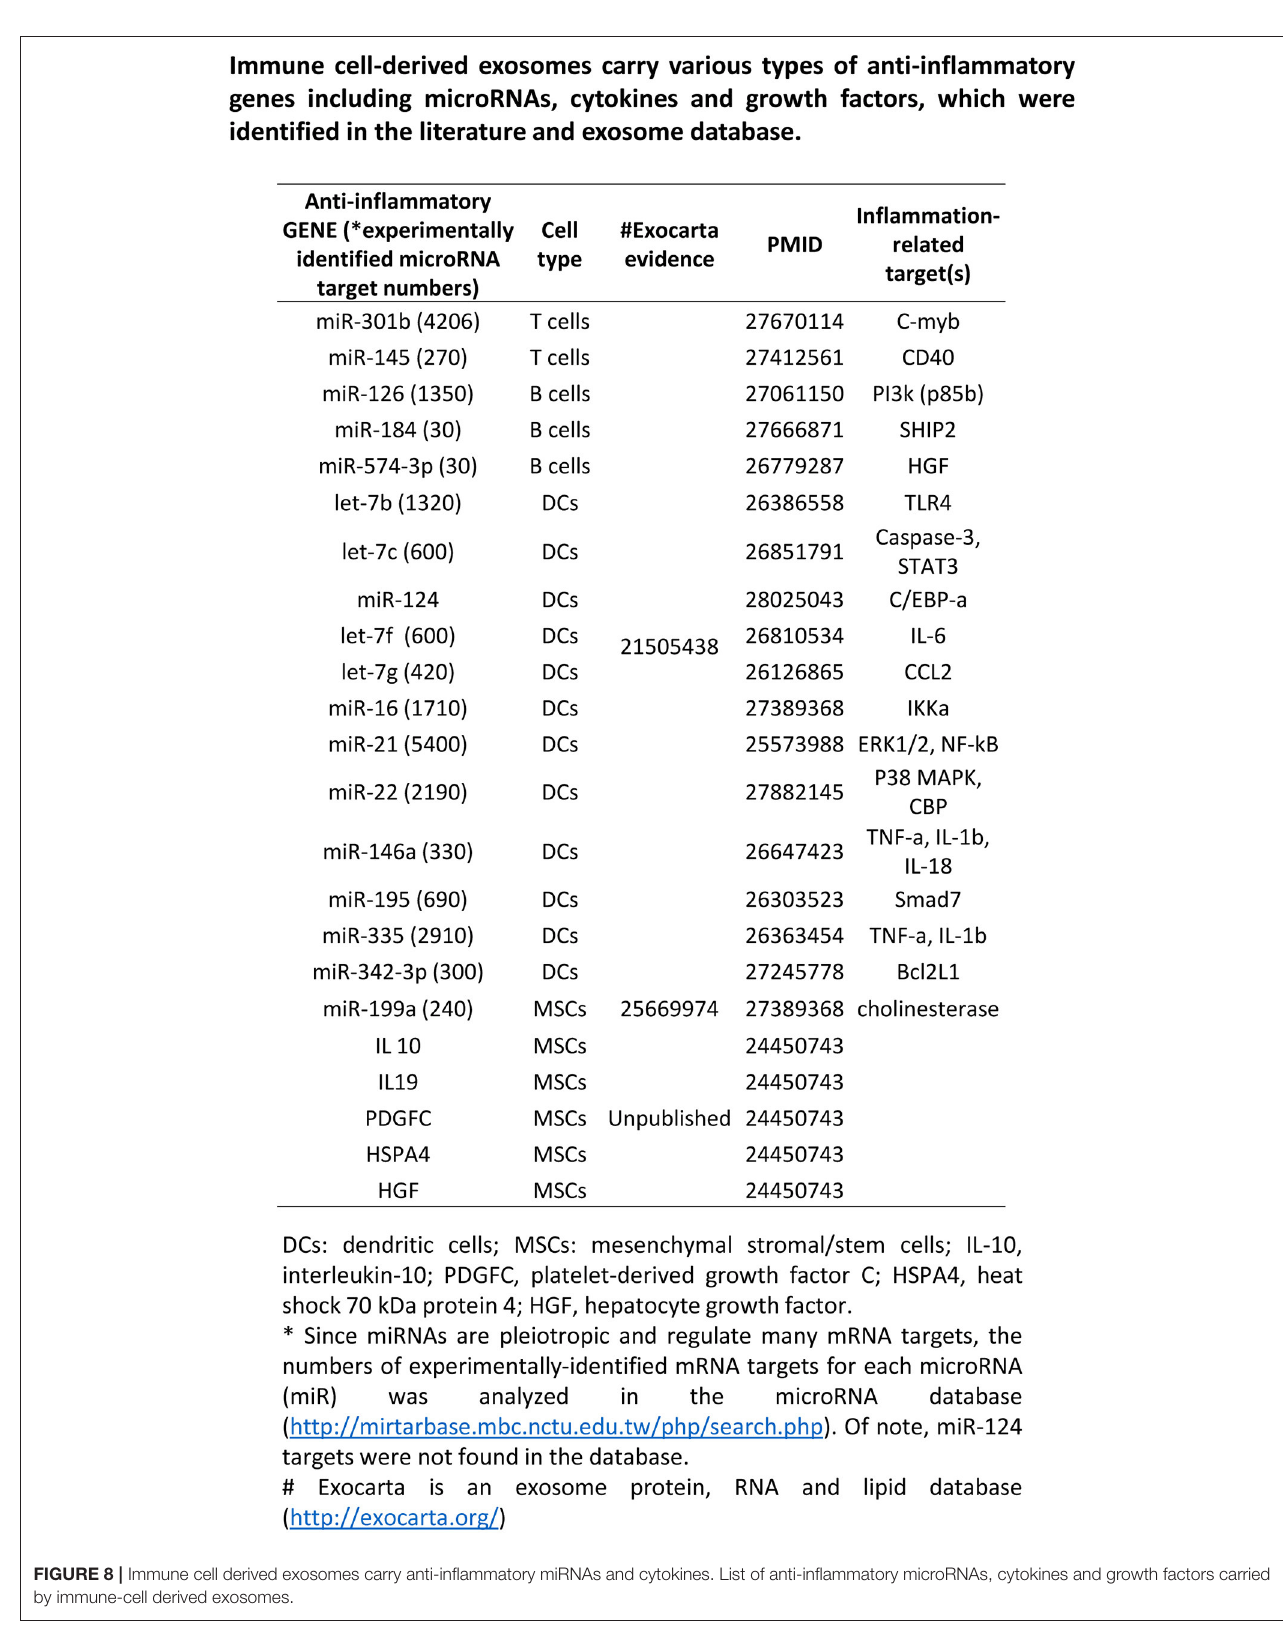
Frontiers in Physiology |